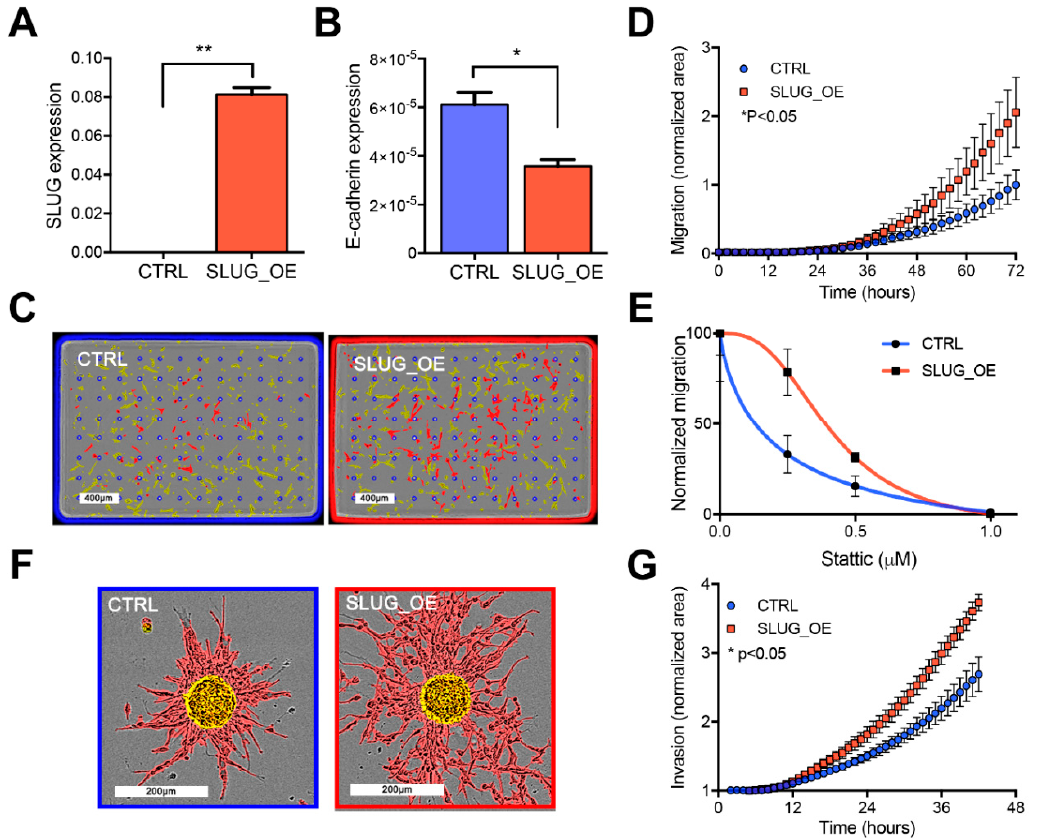
Figure 4. Cont . Figure 4.